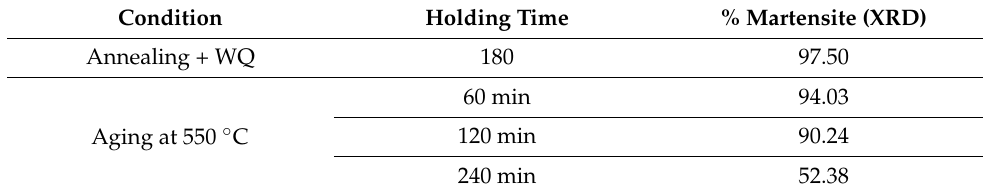
Figure 4. SEM images of M9.8 WQ sample for ( a ) 550 °C, 60 min, ( b ) 550 °C, 120 min, ( c ) 550 °C, 240 Figure 4. min. ( c ) 550 ◦ C, 240 min. Table 2. Martensite % value after heat